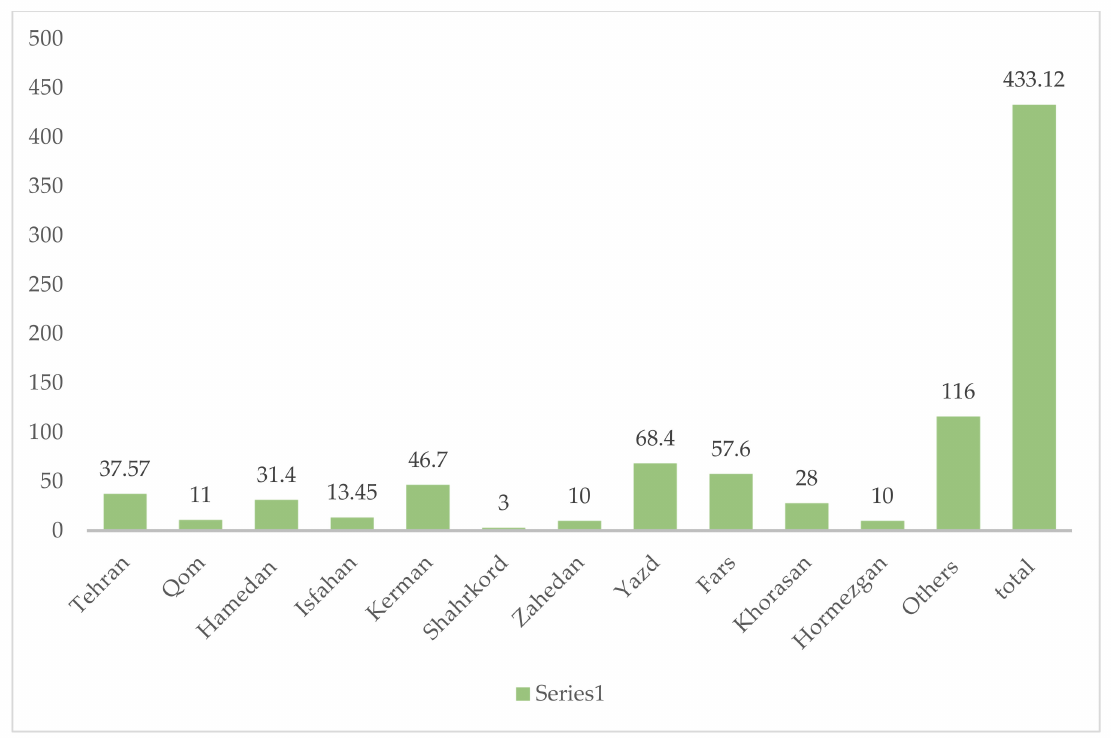
Figure 11. The number of solar power plants in the provinces of Iran [126]. Table 1. Electricity production in June 2021 and the cumulative (until July) in Iran.